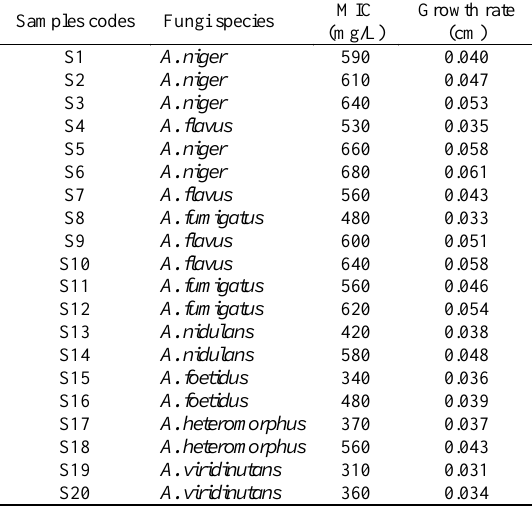
Table 8: Minimum incubatory concentration (MIC) and growth rate of isolated fungi species Samples